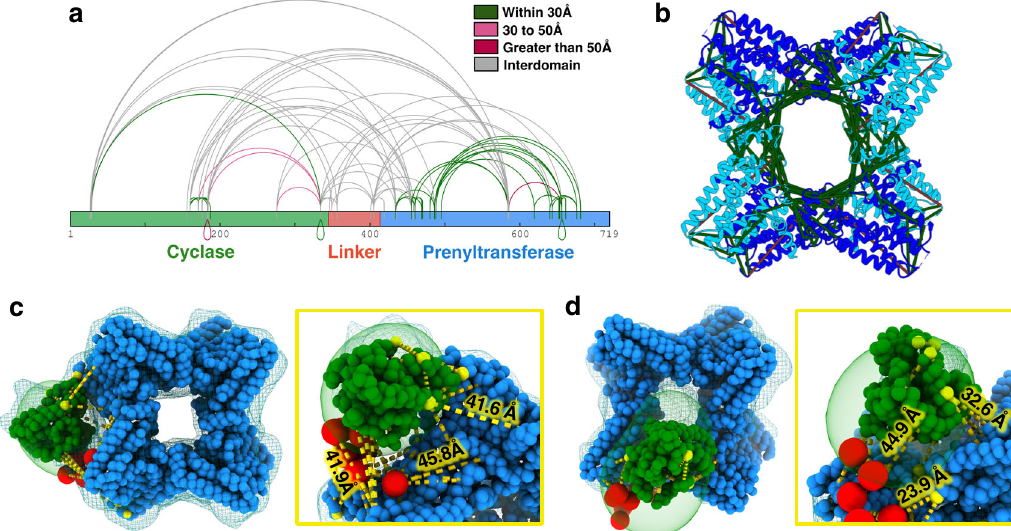
Fig. 4 Intramolecular crosslinks observed by XL-MS. a Schematic representation of all observed crosslinks in full-length PaFS generated using xiView. Crosslinks are colored according to experimentally determined C α – C α distances: intra-cyclase interactions measured in the crystallographic dimer of the cyclase domain (PDB 5ER8) and intra-prenyltransferase interactions are measured in the cryo-EM structure of the prenyltransferase octamer. b Crosslinks between prenyltransferase domains in the octamer; green crosslinks indicate C α – C α separations < 30 Å and magenta crosslinks indicate C α – C α separations > 30 Å. c Integrative model of a single N-terminal cyclase domain and linker position relative to the prenyltransferase core. The moderate- resolution cryo-EM map of the prenyltransferase octamer with one cyclase domain (SE Class A) is displayed as blue mesh (contour 0.015), and the local probability density (LPD) of an individual cyclase domain resulting from IMP simulation is shown with a green surface. A model of the cyclase domain best fi t into LPD is shown with green beads, where the X-ray crystal structure of the cyclase is represented by one residue per bead. The linker segment is modeled in red, with 10 residues per bead. Crosslinks are displayed as yellow dashed lines, with atoms harboring crosslinks displayed as yellow beads. d Low-resolution cryo-EM map of the prenyltransferase octamer with a capping cyclase domain displayed as blue mesh (contour 0.025), with the LPD resulting from IMP simulation of a single cyclase domain shown with a green surface. A model of the cyclase domain and linker best fi t from the IMP simulation is similarly shown. The cyclase position is offset from the central pore and represents a plausible location for the cyclase between the positions observed in the cryo-EM maps shown in Fig.